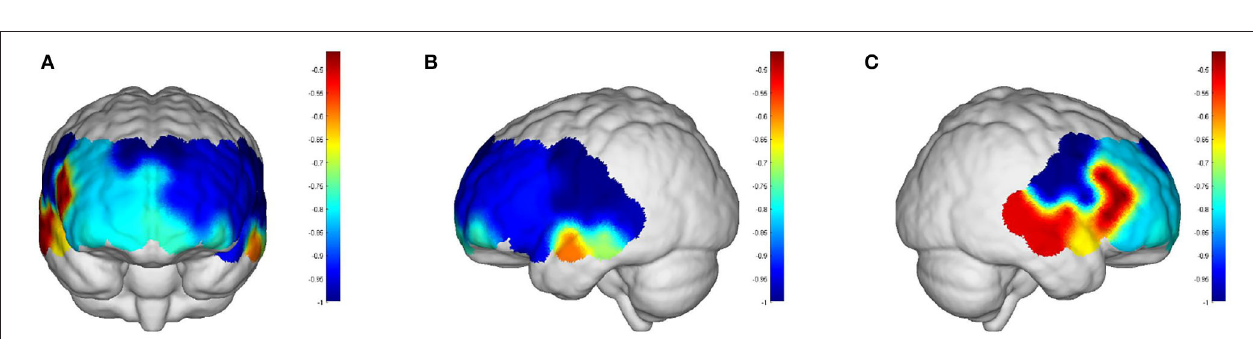
FIGURE 6 | The p- values of the comparison between task values and rest values for young people: (A) front view; (B) left view; (C) right view. The red color represents stronger activation. The red areas are shown in DPLFC, which were p > 0.05.